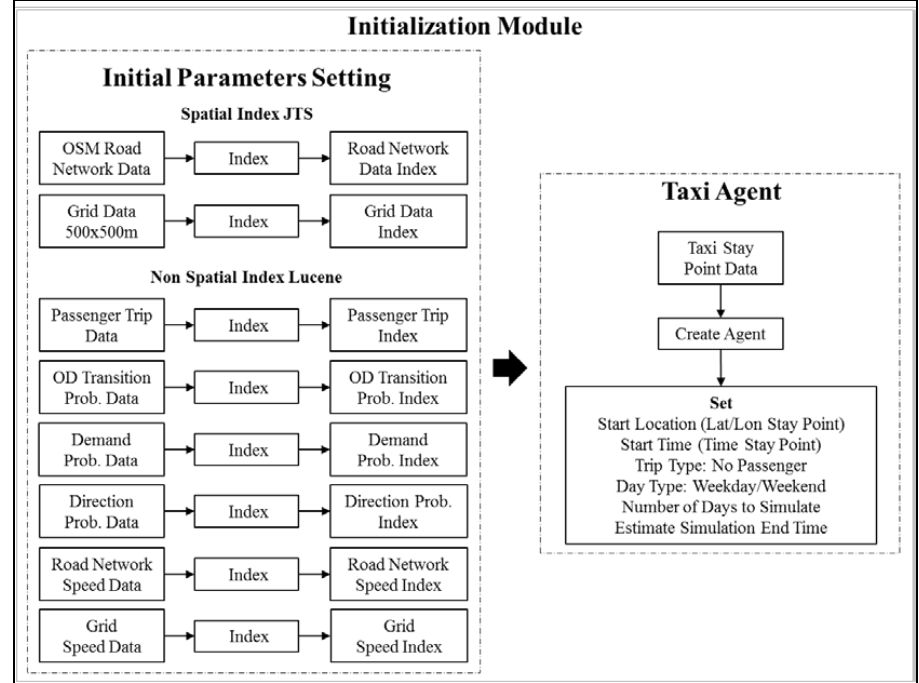
Figure 13. Initialization module.